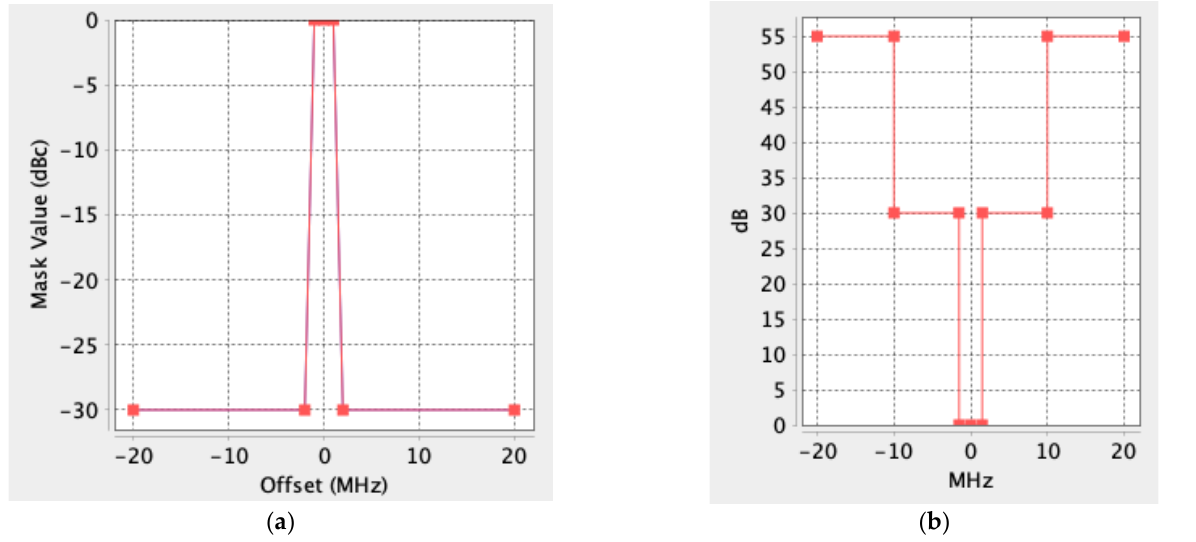
Figure 6. WirelessHART: ( a ) transmitter emission mask; and ( b ) receiver-blocking mask.